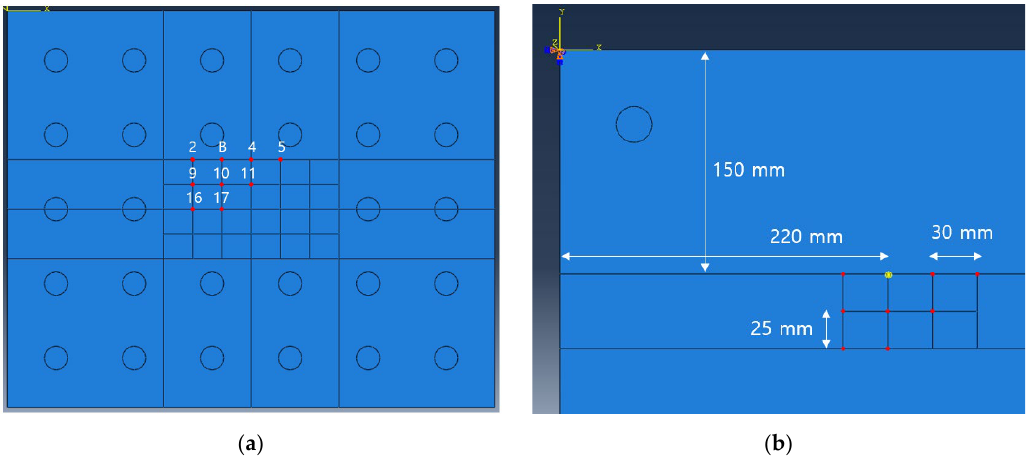
Figure 12. Averaged magnitude of the reflected wave from ‘one’ sensor (rearranged in order from the largest value of the averaged amplitude).